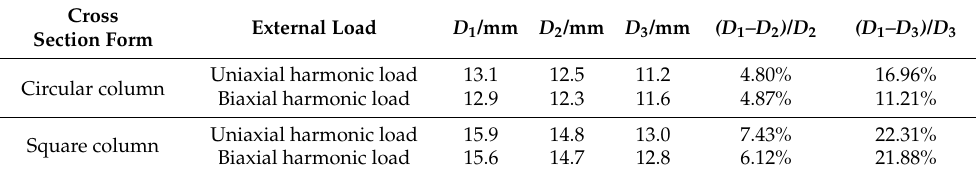
Table 3. The comparison results of the maximum of column top displacement in the above three